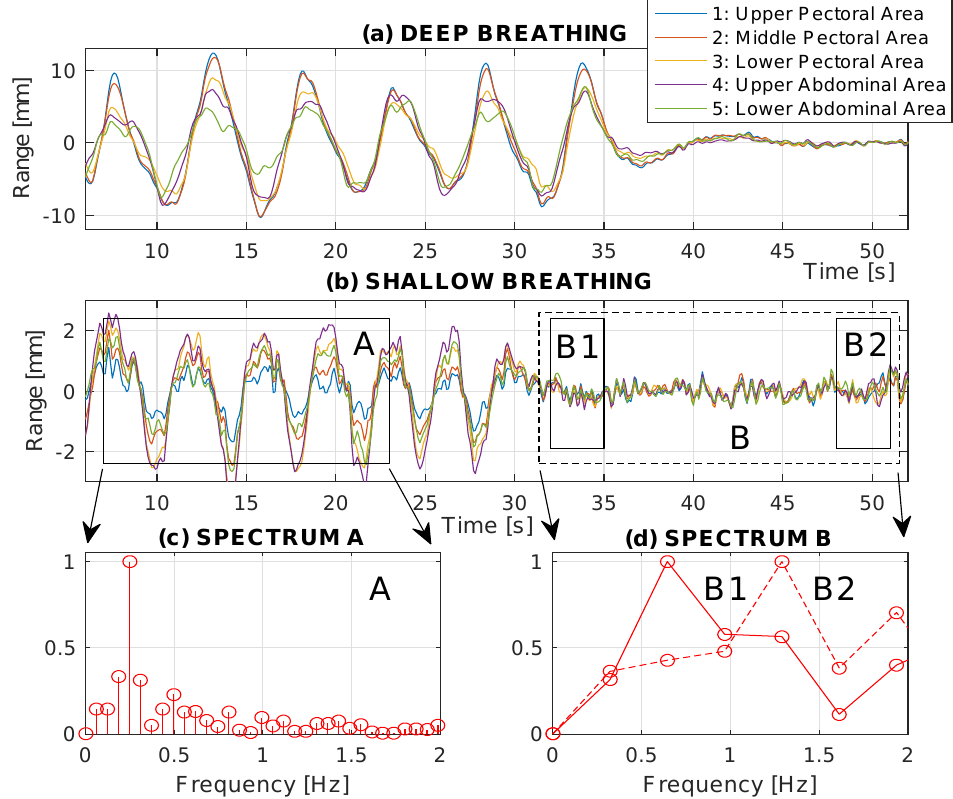
Figure 8. Comparison of breathing patterns in different parts of the chest (specified in Figure 2b) presenting ( a ) deep and ( b ) shallow breathing, showing interrupted breathing in the final part of each record; ( c ) associated spectral components in window A with the dominant breathing frequency of 0.27 Hz (16.2 breaths per minute); and ( d ) spectral components in subwindows B1 and B2 with the dominant heart rate frequency of 0.69 Hz (41.4 bpm) and 1.34 Hz (80.3 bpm),